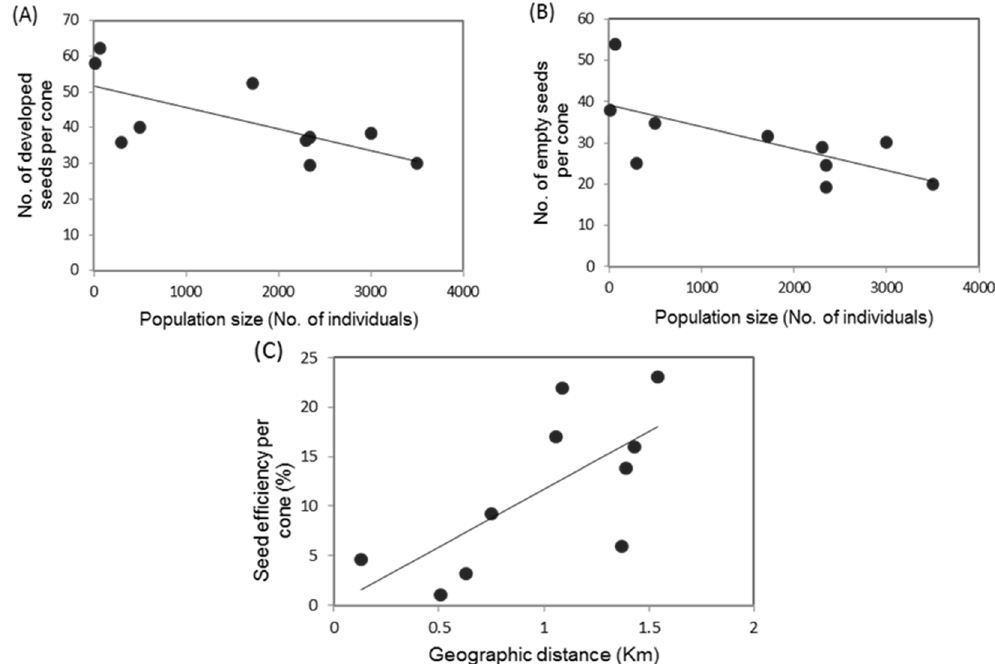
Figure 5. Association of reproductive indicators with population size and geographic distribution. ( A ) Relationship between population sizes and mean number of developed seeds ( y = − 0.006x + 51.657; r = − 0.676); and ( B ) mean number of empty seeds ( y = − 0.0053x + 39.193; r = − 0.673) from Rzedowski’s pine. ( C ) Relationship between seed efficiency and geographic distance in veitchii pine ( Z = 232 out of the 1000 permuted data sets greater than or equal to the original Z ‐ score from the mantel Test).